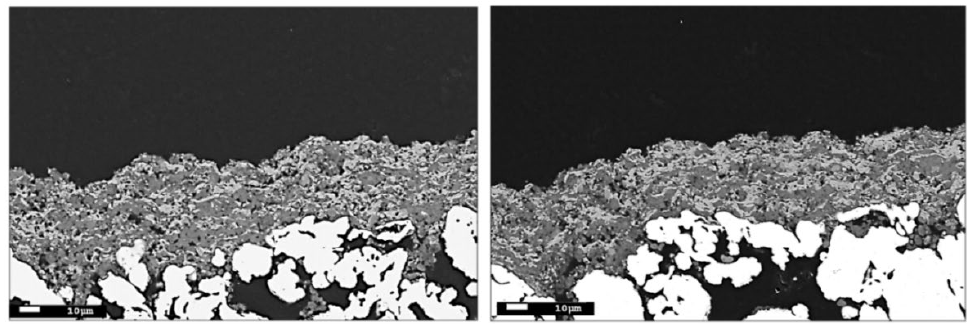
Figure 11. SEM micrographs of two positions on the polished cross-section of M-4 after the pure water permeability measurement.